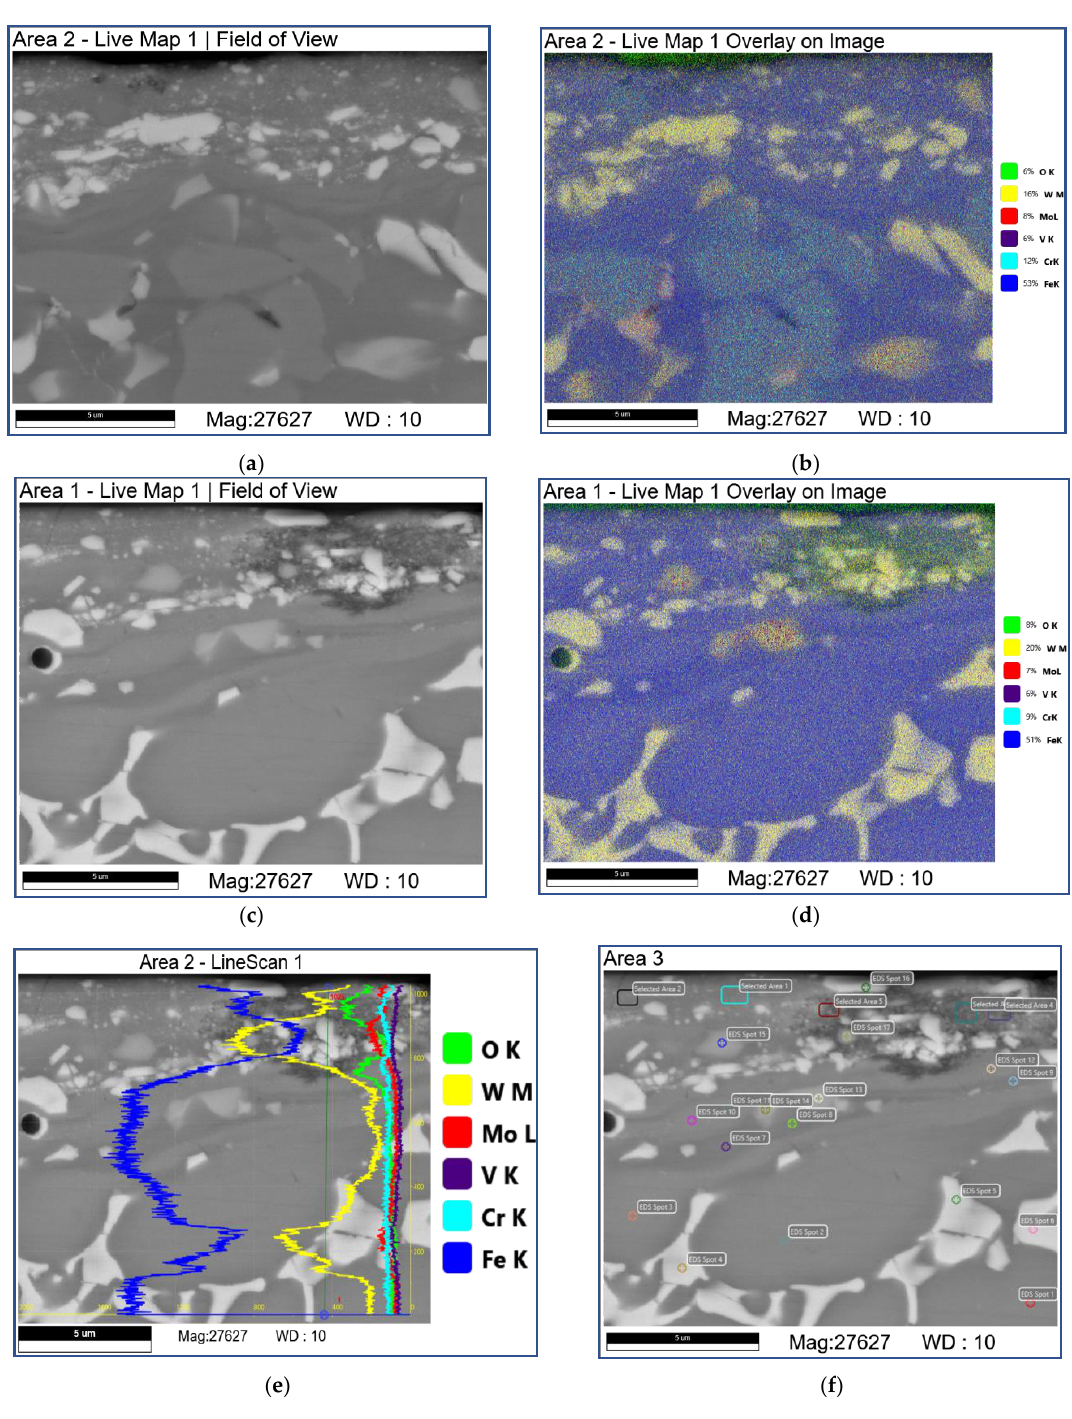
Figure 16. The SEM BSE images ( a – c , e , f ), overlay EDS images ( b , d ) and EDS line scans ( e ) of the subsurface M2/W coating microstructures formed by sliding. Data presented for specimens on sliding speed of 3.6 m/s. Numbers on ( f ) indicate probe zones for which EDS elemental concentrations were determined indicated in Table 7. Table 7. EDS elemental composition of the subsurface area on coating M2/W after sliding at 3.6 m/s (Figure 16f) .